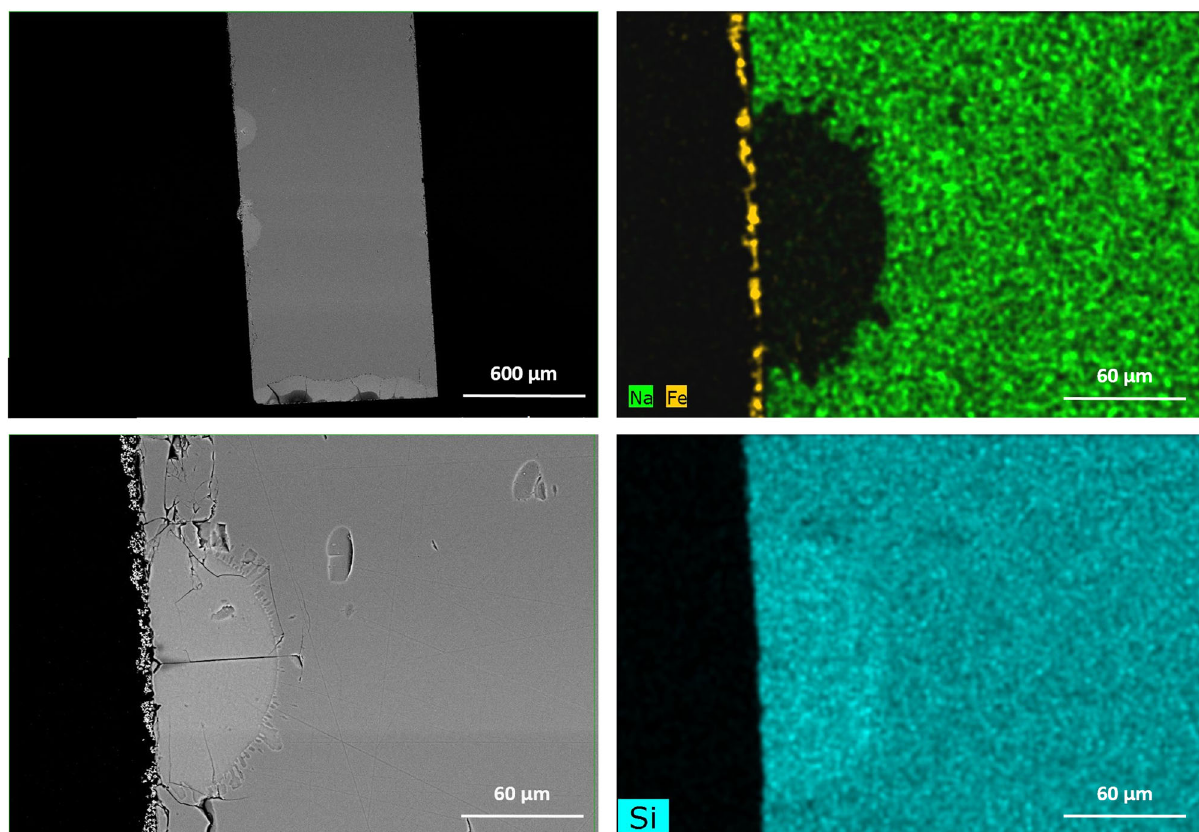
Fig. 8 SEM images of day 358 non-polished surface of the monolith. In the upper left , the total monolith is shown with the polished side on the right. Areas of enhanced alteration are seen on all unpolished surfaces. Bottom left image shows a magni fi cation of one of the altered areas that surrounds a crack in the surface. The images on the right show EDS mapping of signi fi cant elements denoting the alteration area and a concentrated area of iron on the